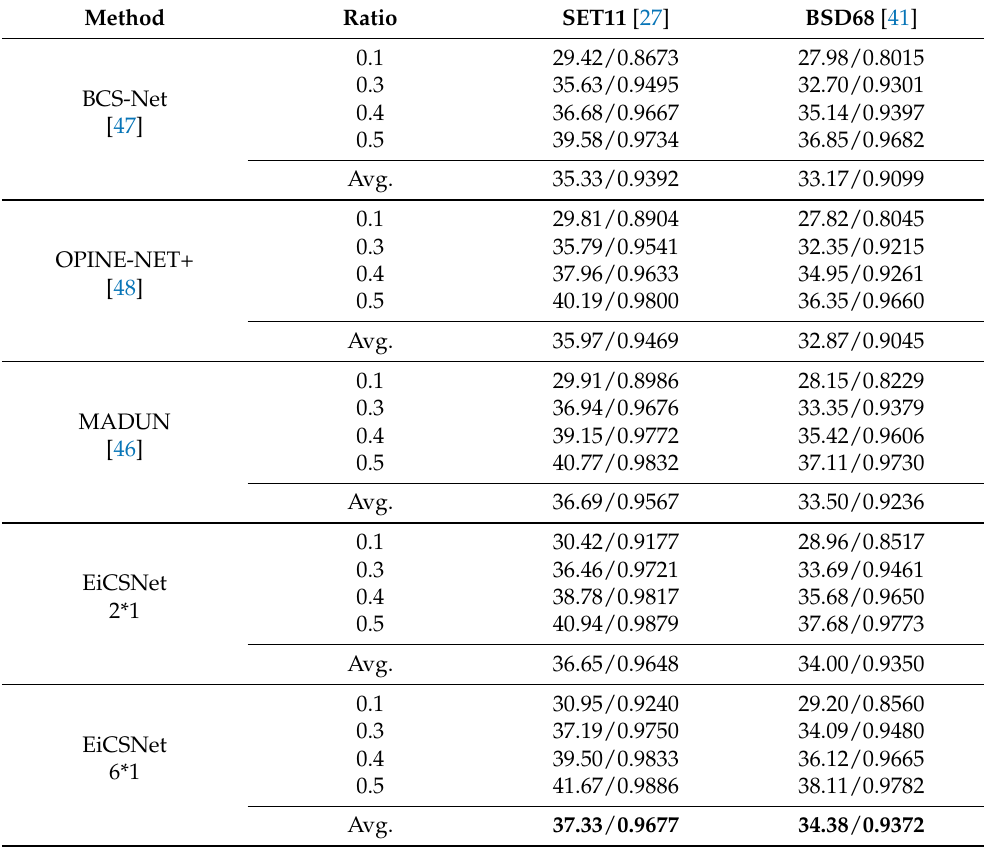
Table 5. The performance results of the different methods under the testing datasets SET11 [27] and BSD68 [41]. The indicators are shown in PSNR/SSIM format. The best indicators are marked in bold for each